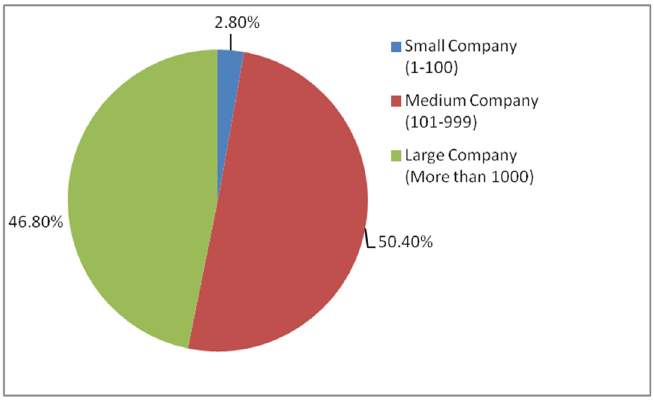
Figure 15. Organisation size.